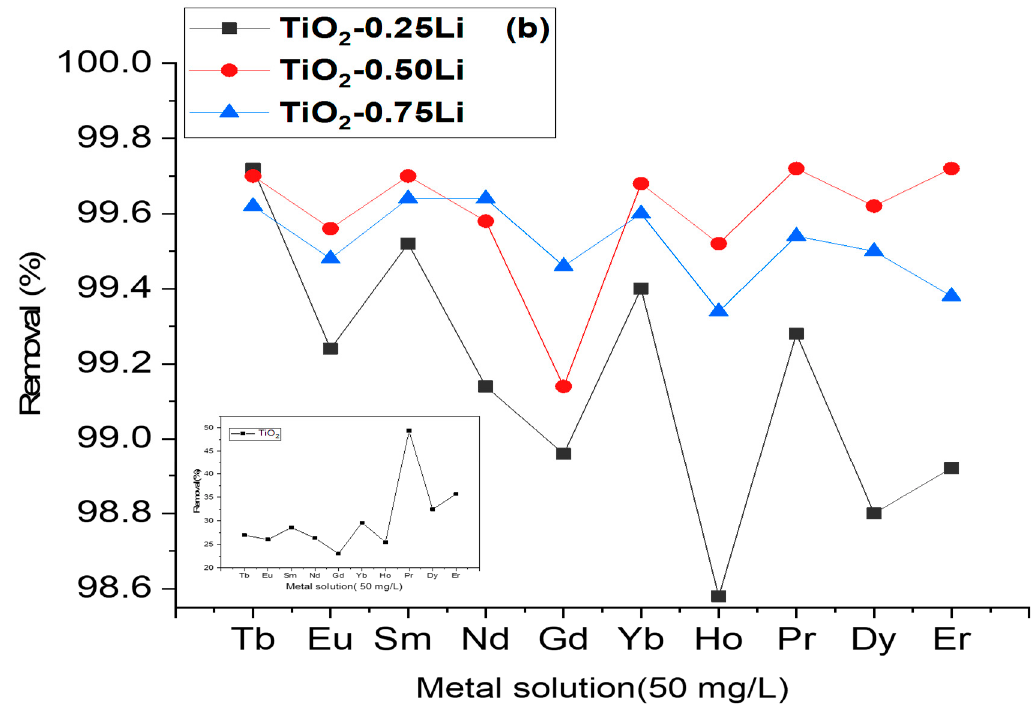
Figure 7. The adsorption efficiency of rare earth elements (REEs) using different nanomaterials.